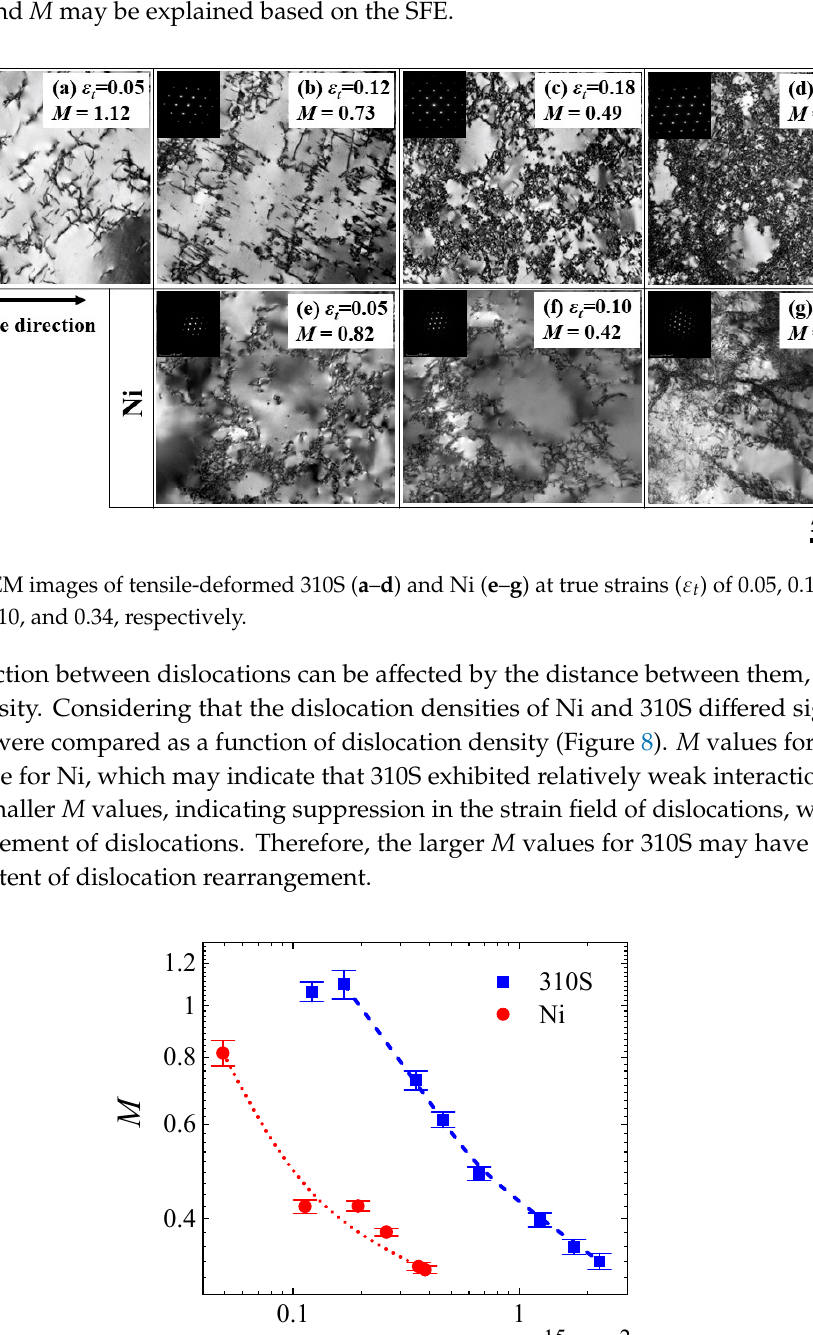
Figure 6. Variations due to true strain for the 310S and Ni specimens in ( a ) FWHMs and 𝑊 (cid:2896) 𝑊 (cid:2891) ⁄ of 220 reflection; ( b ) dislocation density and M .